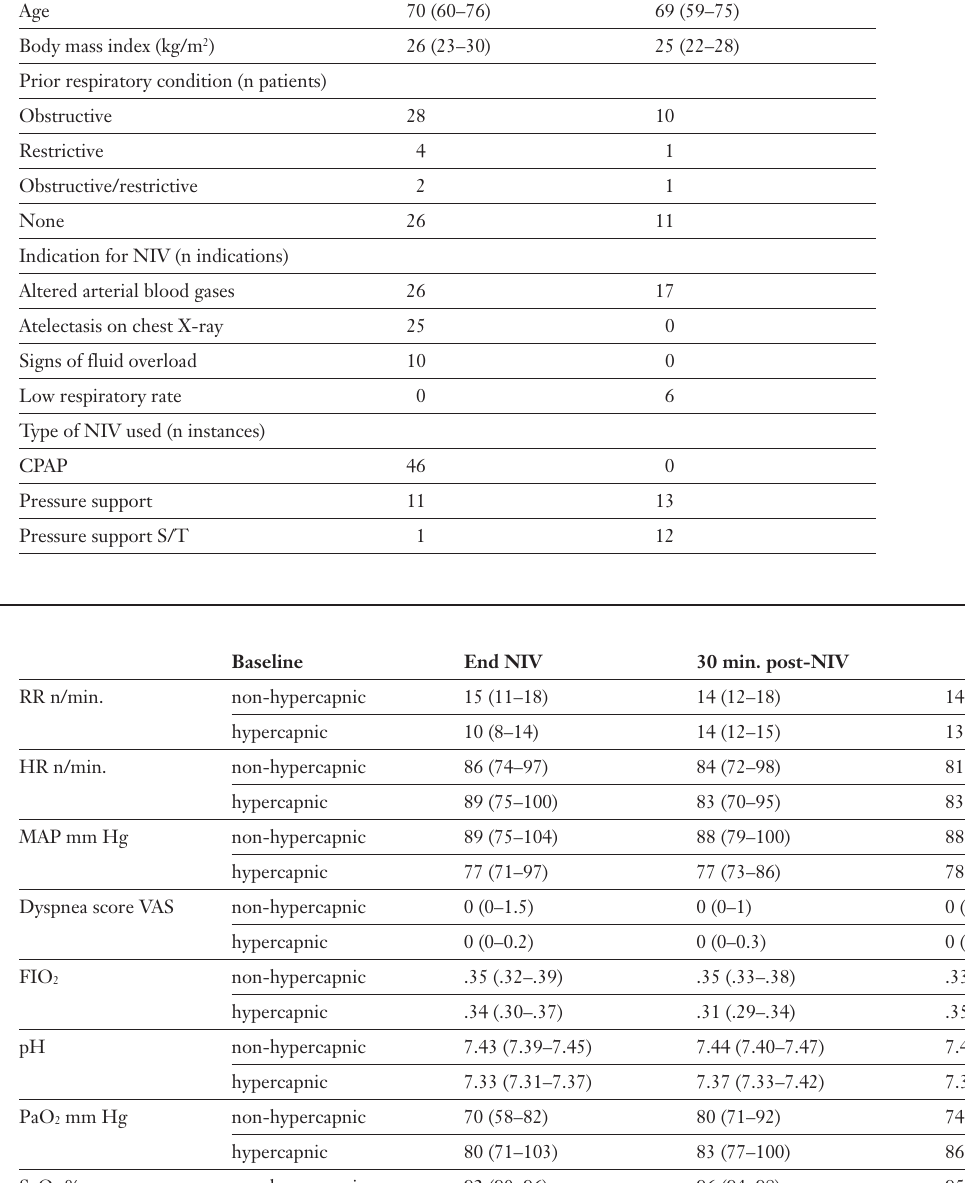
Table 2 NIV indications and modalities in the two patient groups. Values reported as median (IQR).